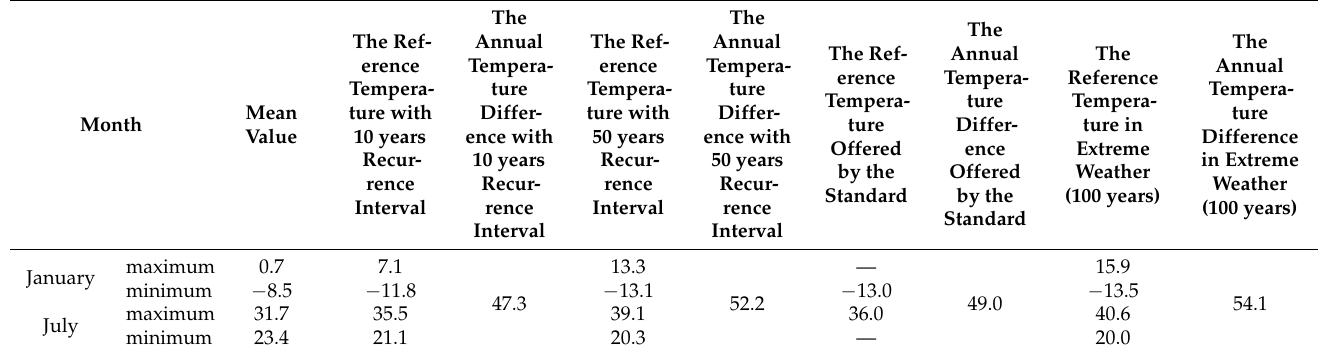
Table 3. Comparison of standard and calculated annual temperature difference in